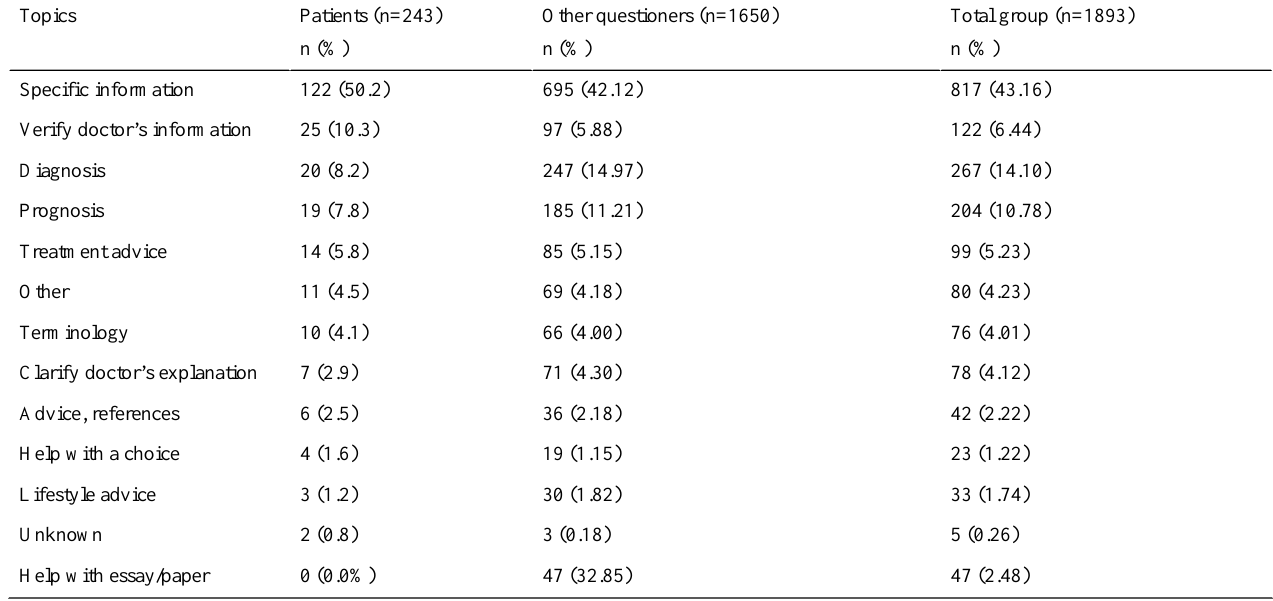
Table 4. What was asked in the first instance: topics, patients, and other questioners.